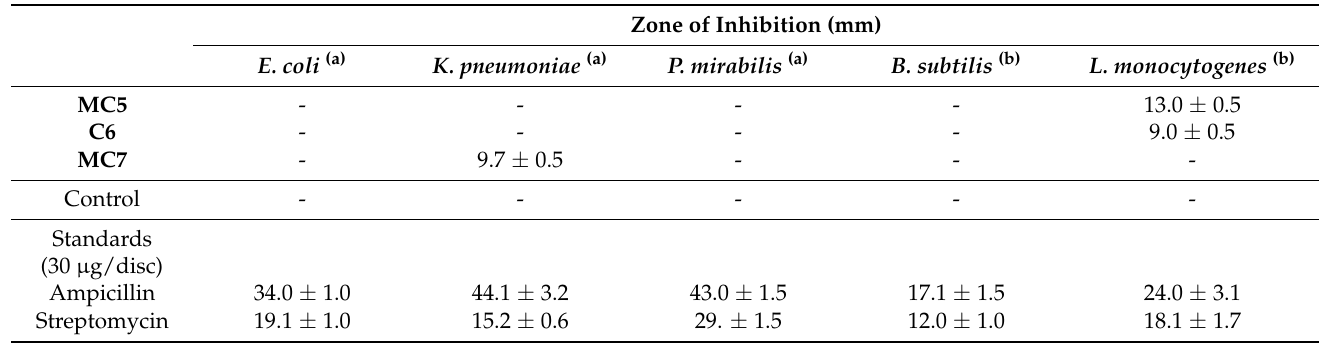
Table 6. Antibacterial activity of the isolated compounds extracted from kava